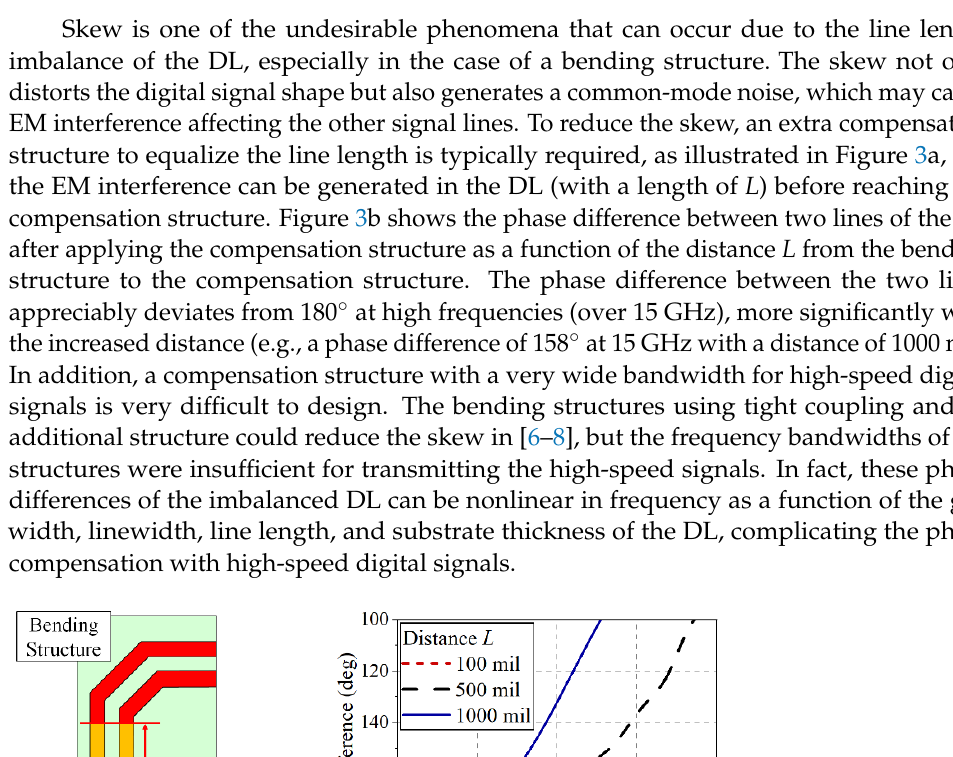
Figure 2. Examples of complex structures in a high-speed circuit board causing the common-mode noise.